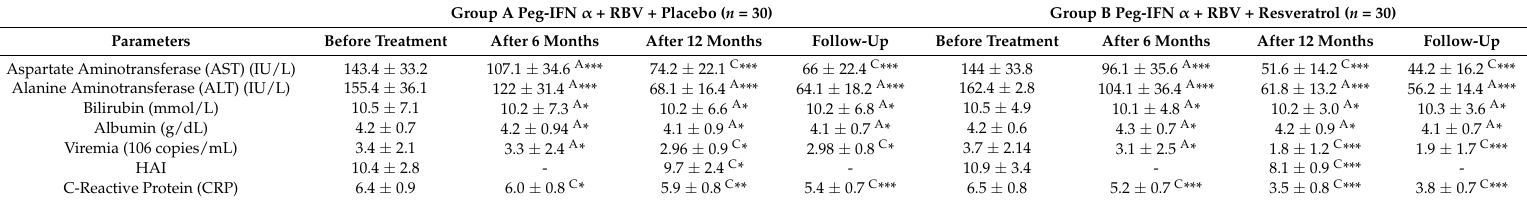
Table 2. Characteristics of subjects at baseline, after 6 and 12 months, and at follow-up. Values are expressed as Mean ± SD.